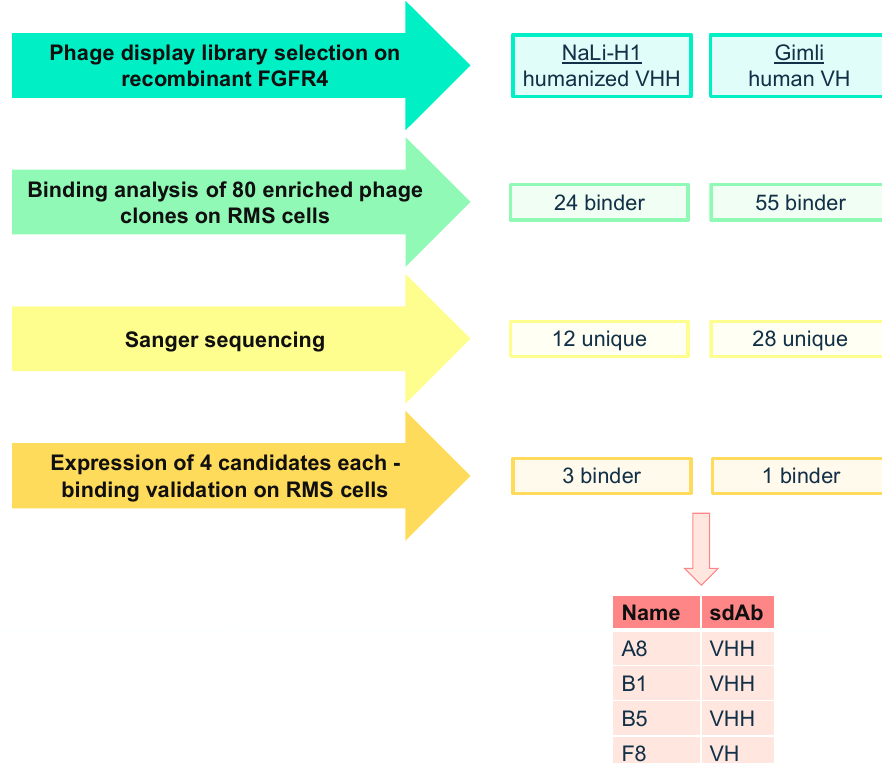
Figure 1. Schematic overview of phage display biopanning and preselection of FGFR4 binding single-domain antibodies (sdAb) sequences. Phage display selection was performed on biotinylated and Dynabeads-bound FGFR4 with two different synthetic sdAb phage display libraries. Enriched phage clones were tested for their binding to cell-surface FGFR4 on Rh4-FR4wt cells resulting in 40 unique binders. Eight sdAb were expressed in E. coli and purified. Of these, recombinant A8, B1, B5 and F8 bound to Rh4-FR4wt but not to Rh4-FR4ko cells.